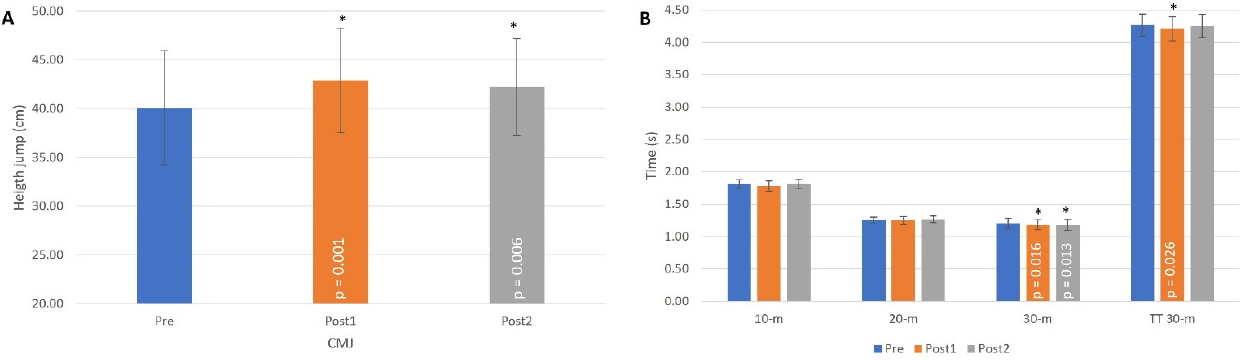
Table 1. Changes in performance after the first three-week period (pre- to post-1) of flywheel training.